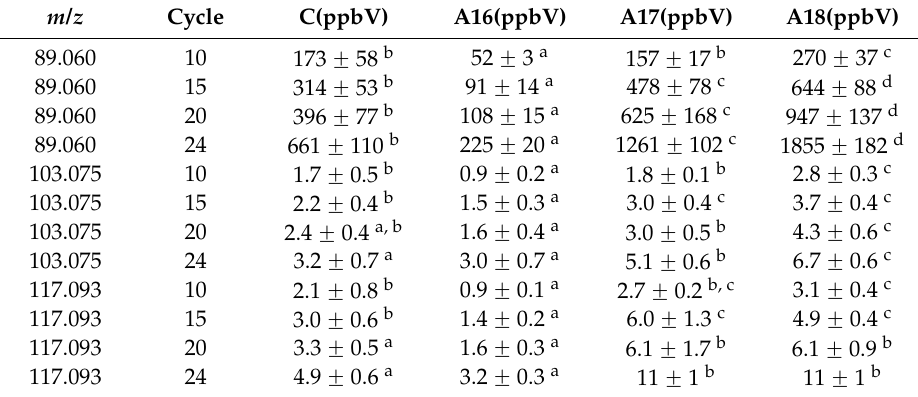
Table 2. Concentrations (in ppb V ) for the mass peak m / z 89.059, m / z 103.075 and m / z 117.093 corresponding to the cycles 10, 15, 20, and 24 (leavening process driven by S. cerevisiae bakery starter cultures C, A16, A17, and A18).